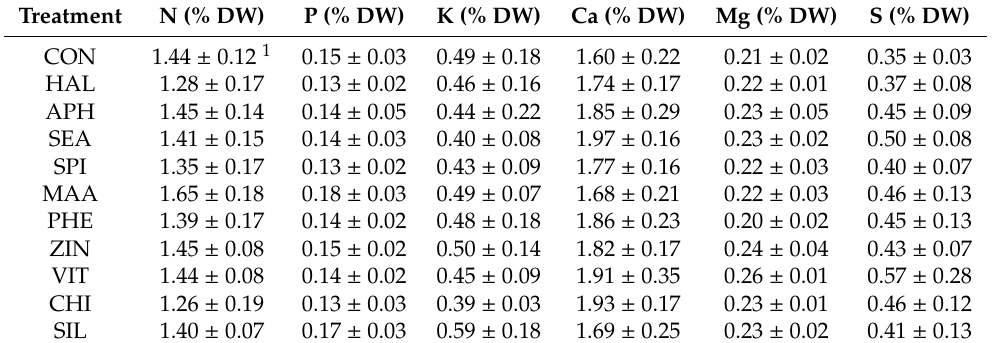
Table 7. Macronutrient concentrations in strawberry roots at 90 DAT (days after transplanting) as a ff ected by biostimulant application.